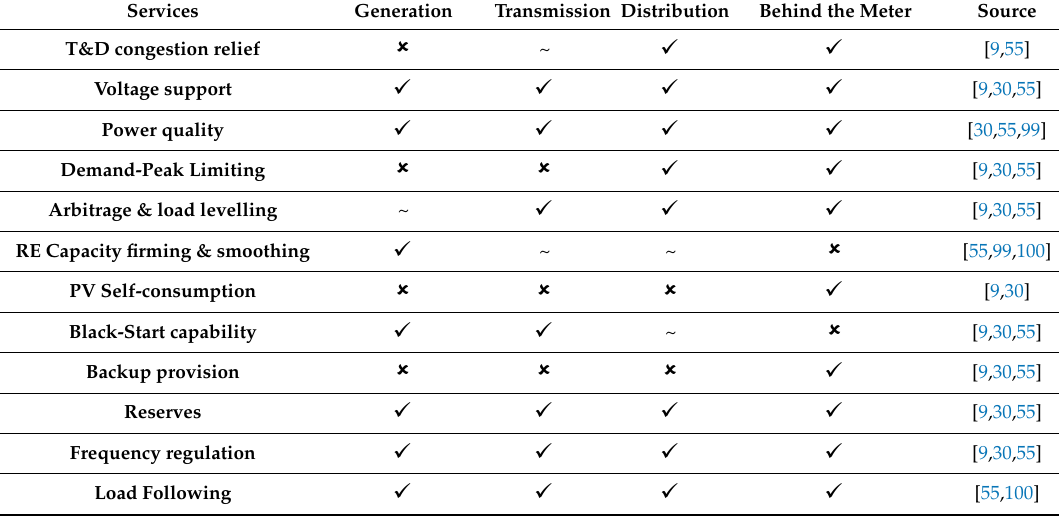
Table 3 . Likelihood of connection at the different electricity network levels.